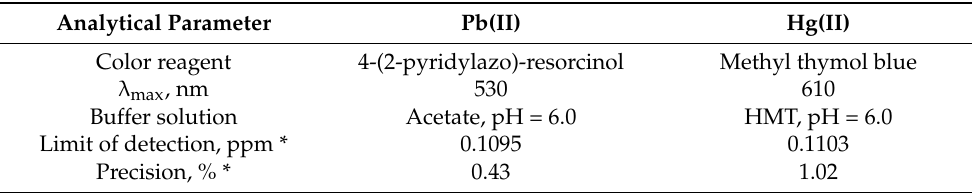
Table 1. Analytical characteristics of the spectrophotometric methods used in the analysis of Pb(II) and Hg(II)